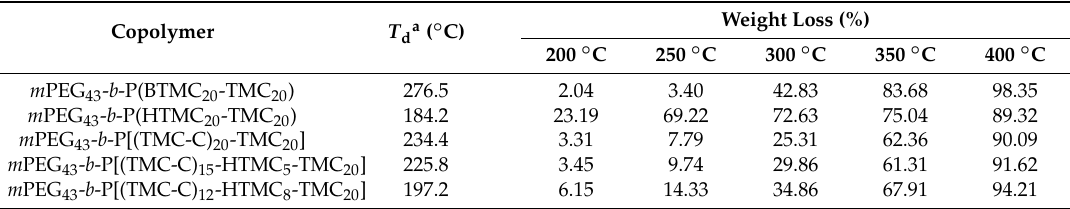
Figure 1. TGA curves of the copolymers. Table 2. TGA data of the copolymers.